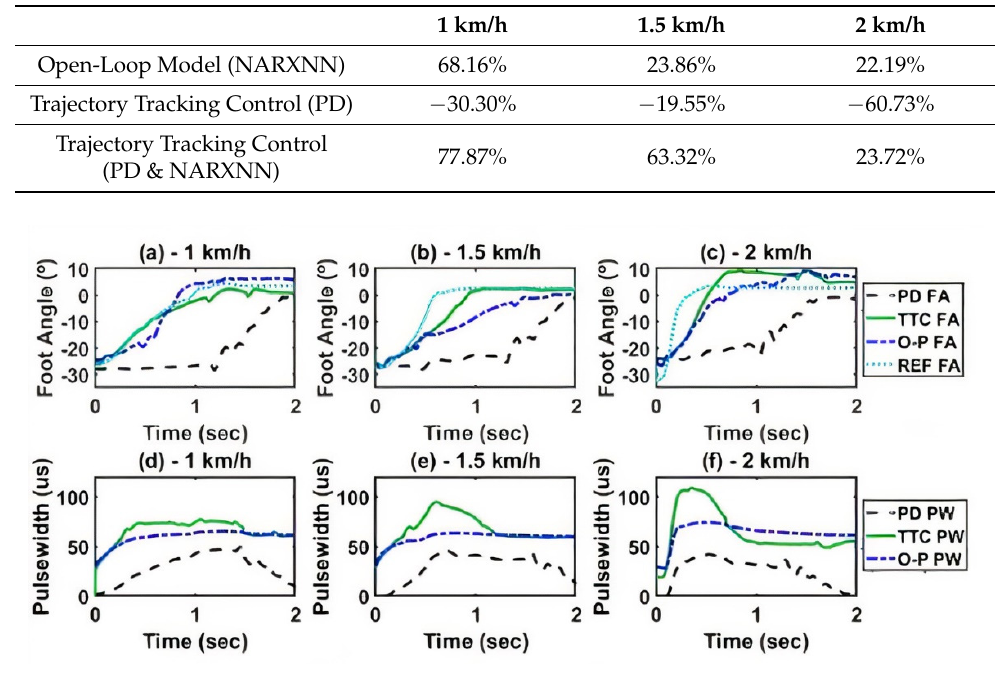
Figure 9. Performance comparison between the different control strategies for phase I protocol for 1 km/h, 1.5 km/h, and 2 km/h speeds. ( a – c ) Foot angle signal obtained from each control strategy for